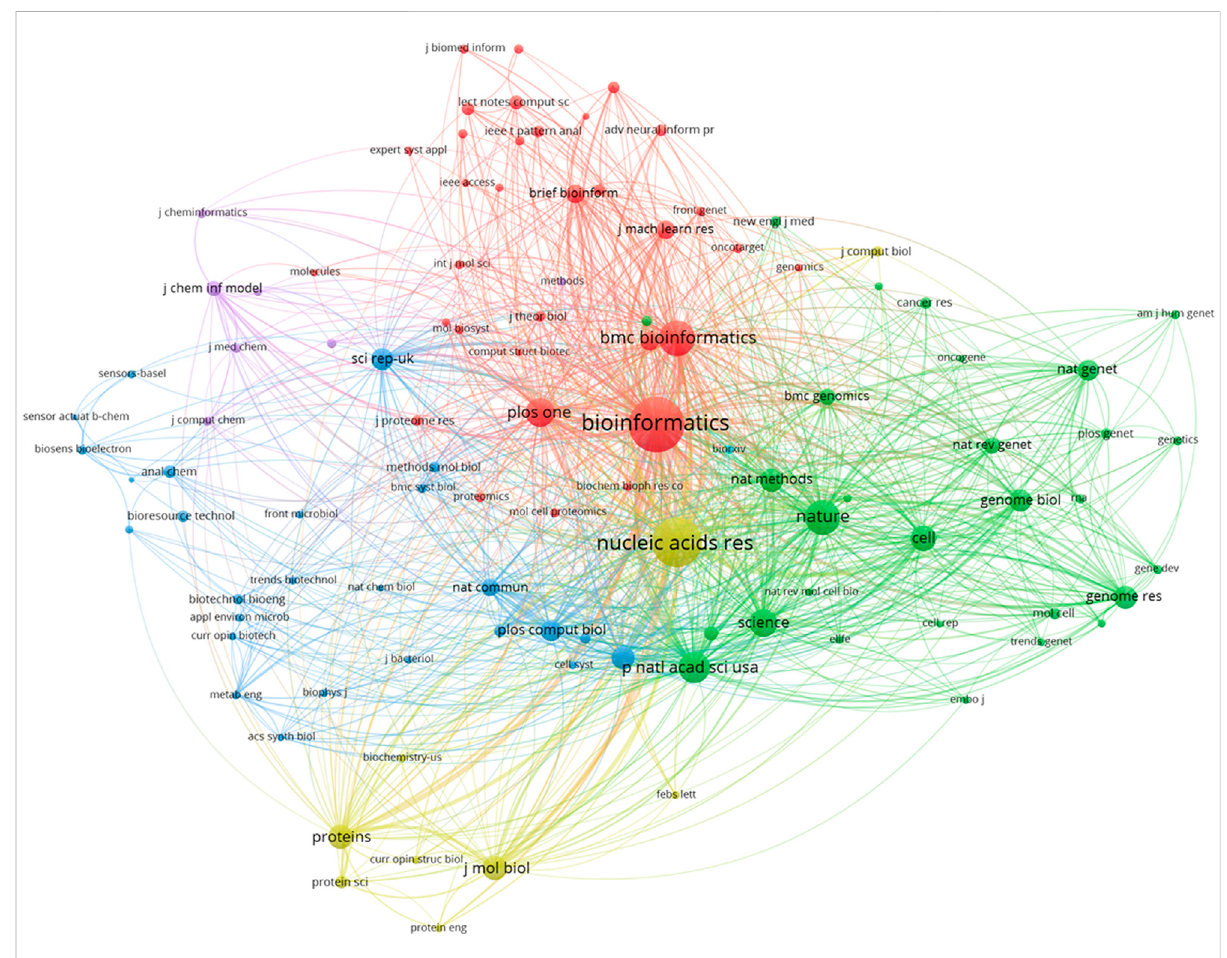
FIGURE 5 The network map of cited journals contributed to